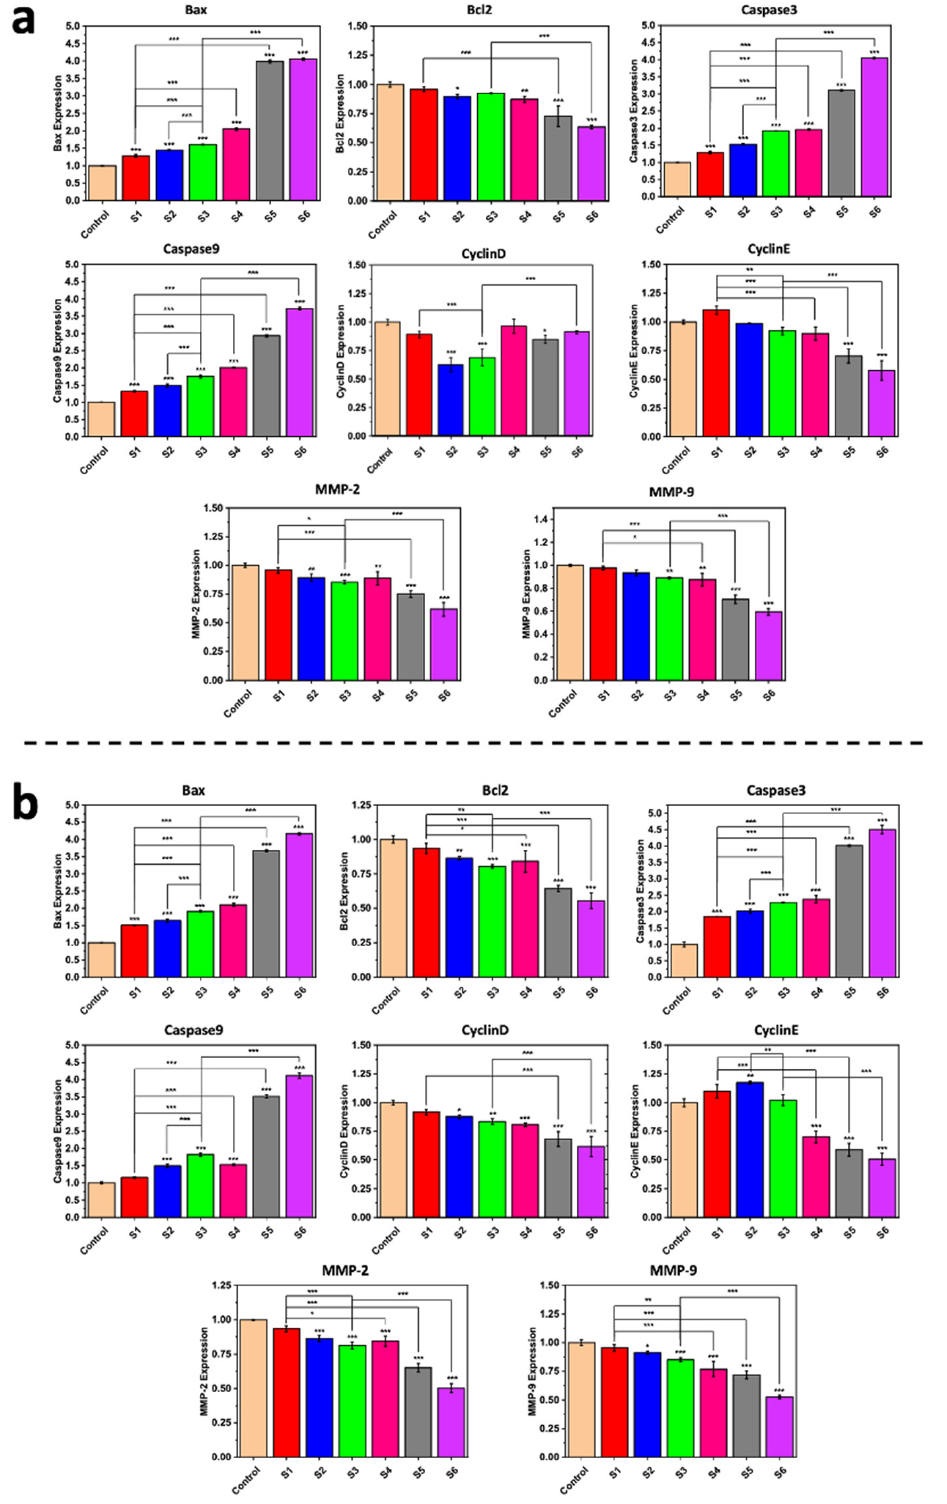
Figure 4. The expression of Bax, Bcl-2, caspase-3, caspase-9, MMP-2, MMP-9, cyclin D, and cyclin E in ( a ) MDA-MB-231 cell line and ( b ) SK-BR-3 cell line. S1: letrozole; S2: curcumin; S3: mixture of letrozole and curcumin; S4: NiCoFe 2 O 4 @L-Silica@Niosome; S5: NiCoFe 2 O 4 @L-Silica@L-Niosome; S6: NiCoFe 2 O 4 @L-Silica@C-Niosome; control: ß-actin (* p < 0.05, ** p < 0.01, *** p < 0.001). Treatments of range concentrations (IC50 concentration) of nano- and free drugs were applied to the cells for 48